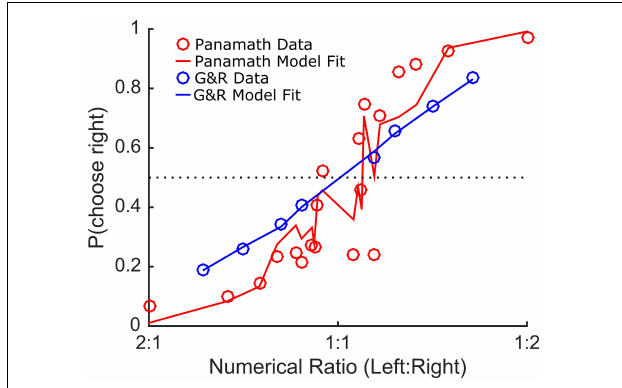
FIGURE 2 | DeWind et al. (2015) model fits the data. Proportion of trials on which participants choose the array on the right side plotted against the left to right numerical ratio (irrespective of non-numerical feature ratio) for Panamath (red circles) and G&R (blue circles). The line shows the predictions of the model fit separately to the data for each protocol collapsing across participant.